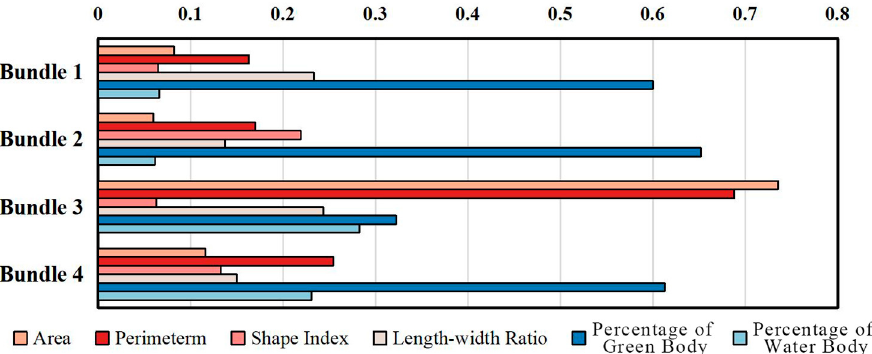
Figure 7. Comparison of the mean values of the urban park characteristic indexes according to the classification of the four cooling effect bundles.